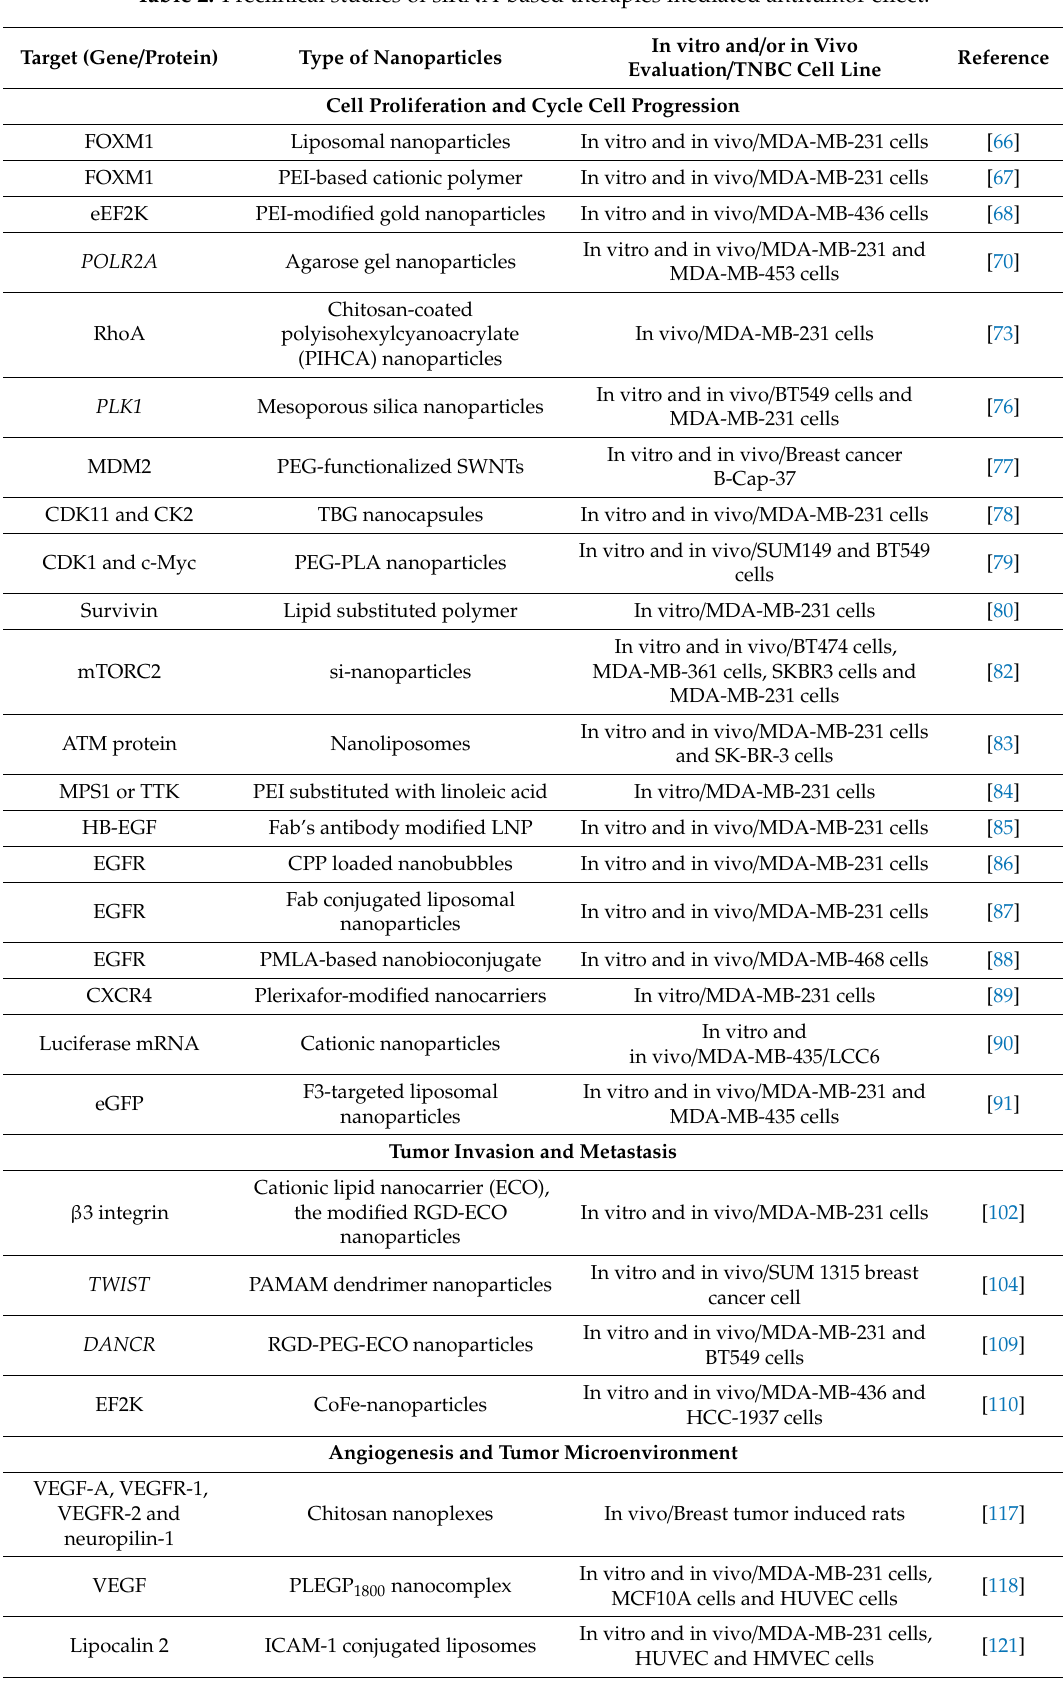
Table 2. Preclinical studies of siRNA-based therapies mediated antitumor e ff ect. Target (Gene /